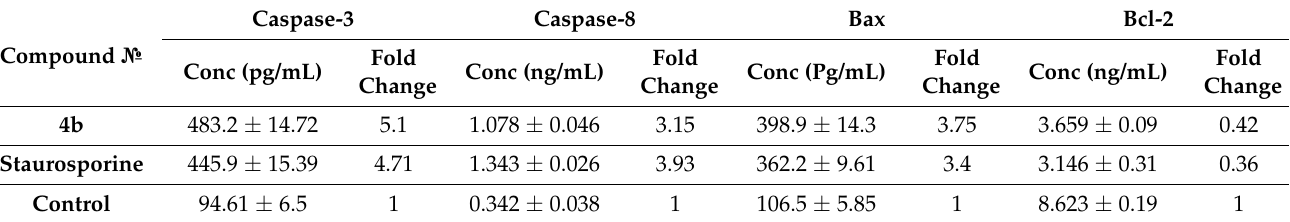
Table 3. Caspase-3, Caspase-8, Bax and Bcl-2 levels for hybrid 4b and staurosporine on HepG2 cancer cell line.